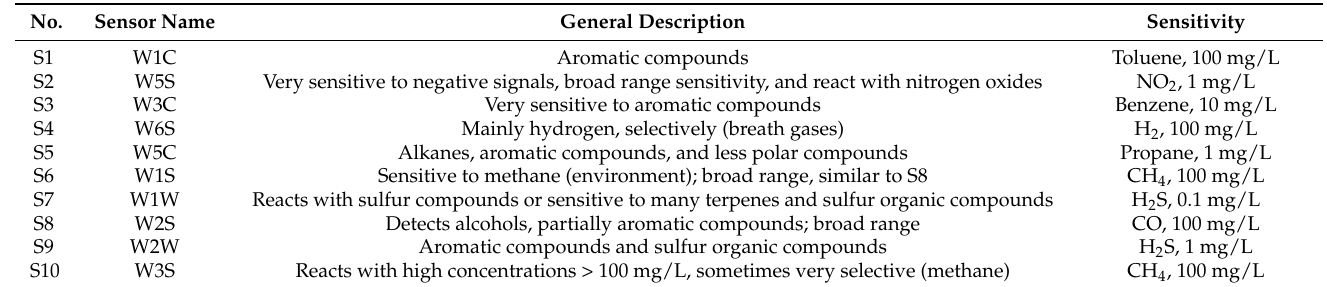
Table 1. Sensors and their main applications in the commercial PEN2 E-Nose [19].